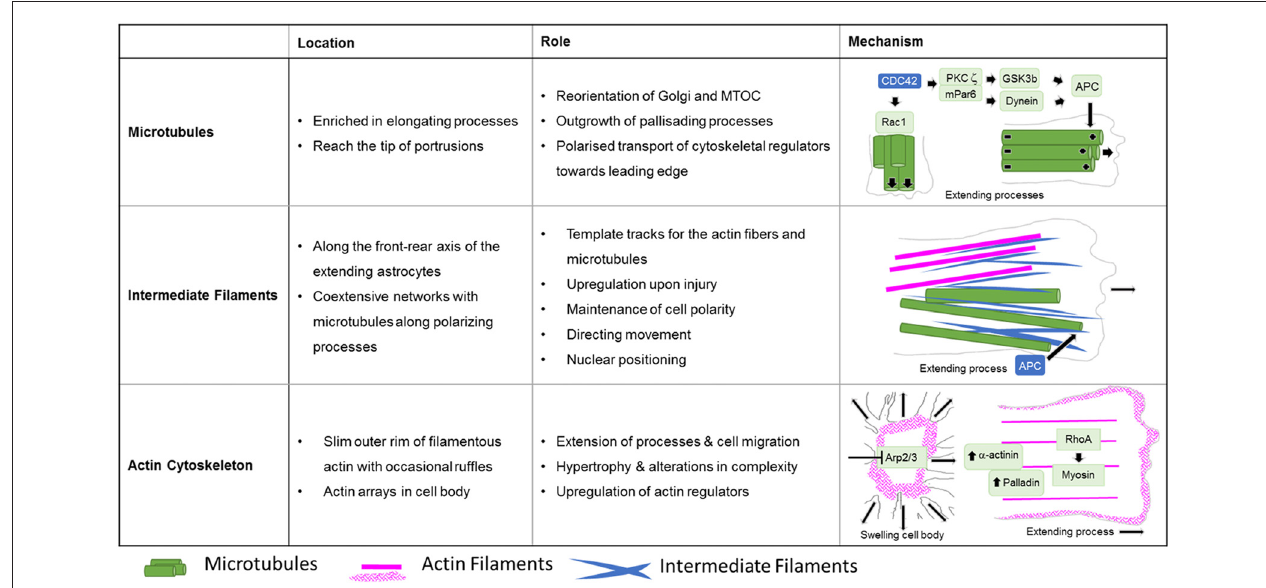
FIGURE 5 | Roles of cytoskeletal systems during the Injury response of astrocytes in vitro . Summary in view of the localization and roles of microtubules, intermediate and actin filaments in cultured astrocytes upon injury. The schematic drawings depict the cytoskeletal systems and their major regulators involved in extension of astrocyte processes and cell body